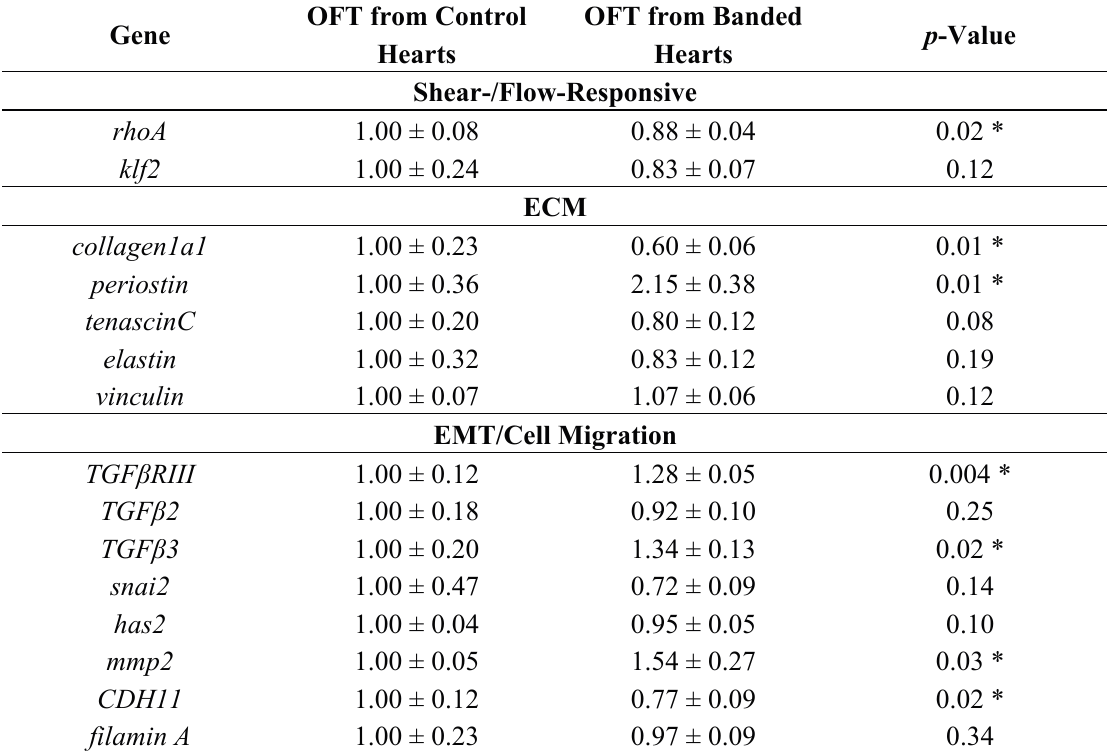
Table 2. Differential expression of genes critical to valve development, upon OFT banding, in OFT tissue of banded and control hearts. * p < 0.05. OFT from Control OFT from Banded p -Value Gene Hearts Hearts Shear-/Flow-Responsive rhoA 1.00 ± 0.08 0.88 ± 0.04 0.02 * klf2 1.00 ± 0.24 0.83 ± 0.07 0.12 collagen1a1 1.00 ±